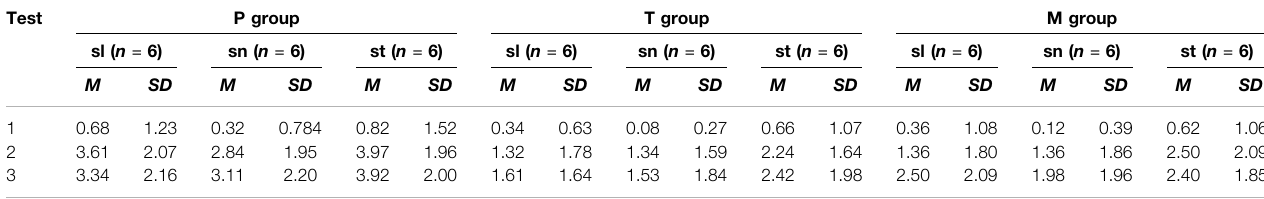
TABLE 2 | Descriptive statistics for sC production over time, across three experimental groups (Mean scores) in Read Aloud test. Test